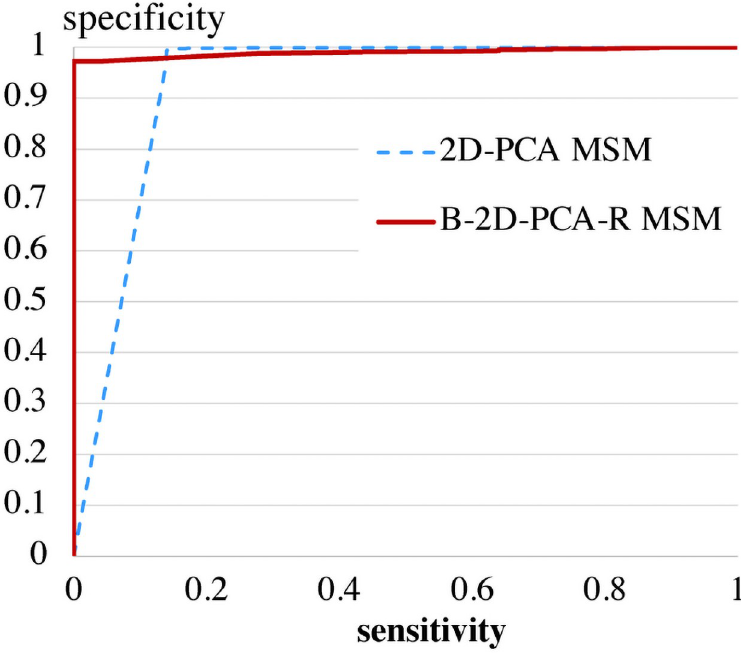
Fig 17. Specificities and sensitivities (defined as TN / ( TN + FP ) and FN / ( FN + TP ), respectively) by changing thresholds of 2D-PCA MSM and B-2D-PCA-R